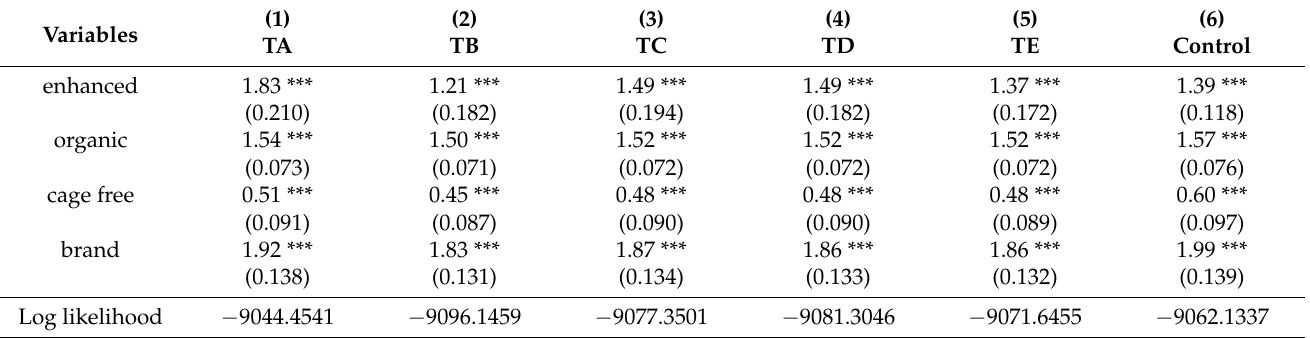
Table 5. Simulated WTP (CNY per egg) for different attributes across treatments and control